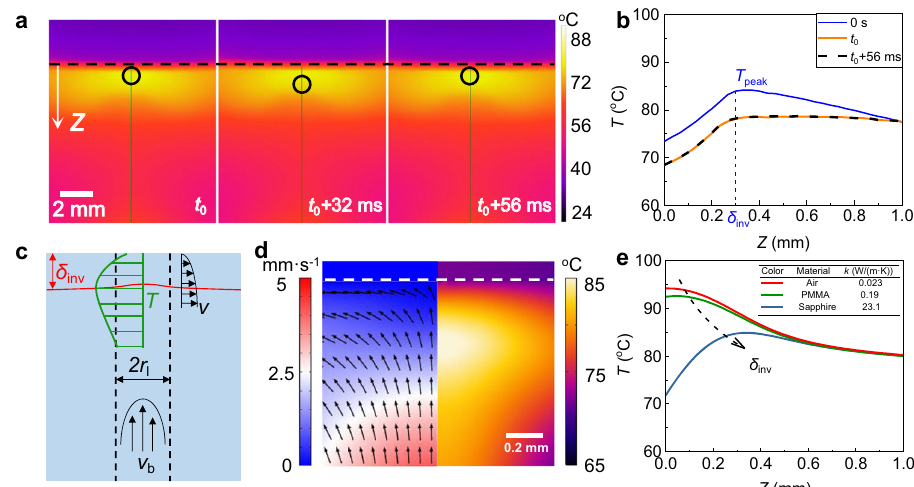
δ inv about 0.3mm and a strong temperature gradient d T /d Z about 50 K/mm (Supplementary Fig. 4). c Sketch for the formation of TIL. d Simulation for the fl ow and temperature, con fi rming T peak for TIL. e T peak arising from the high thermal conductivity of the sapphire glass in simulation. Source data are pro- vided as a Source Data fi